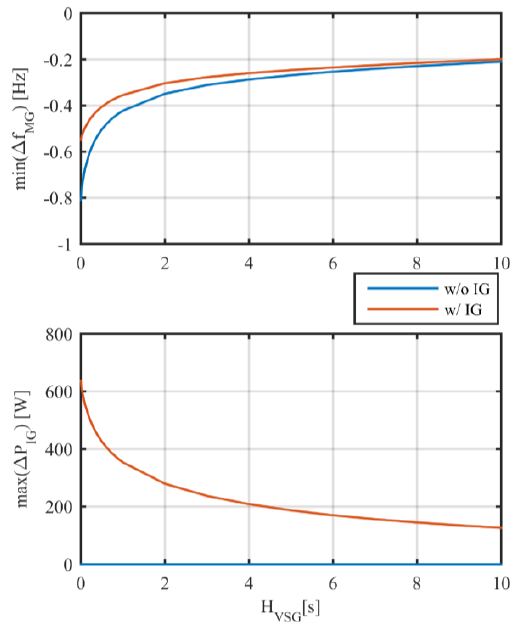
Figure 5. Variation with the MG inertia of the minimum MG frequency and the maximum IG power deviation for a 2 kW load connection.